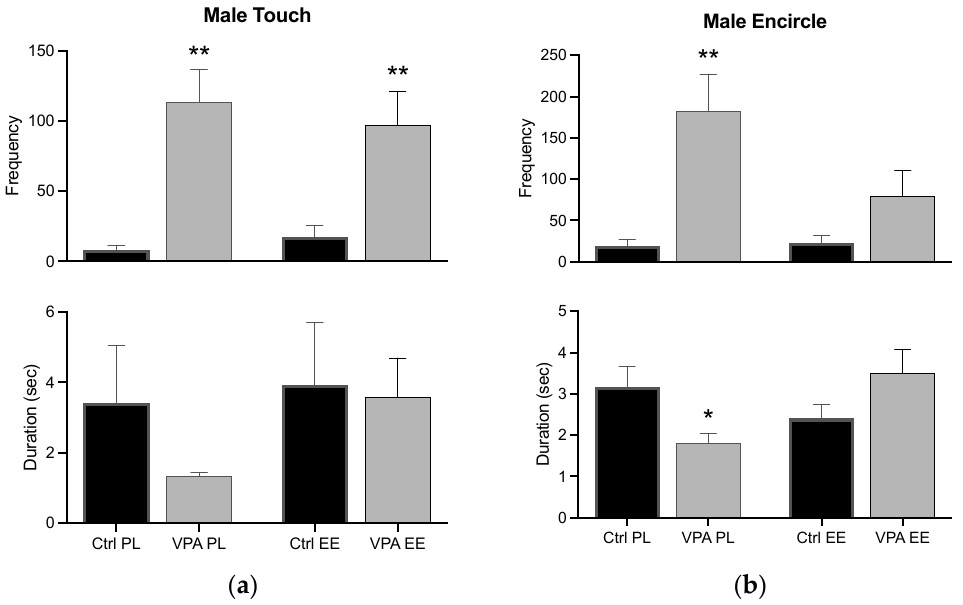
Figure 6. Male preconsummatory behaviors. The graph shows how many times the male touched ( a ) and encircled ( b ) the female (frequency) and how long he displayed such behaviors for (duration). Data show the mean ± SEM. * = p < 0.05; ** = p < 0.01.